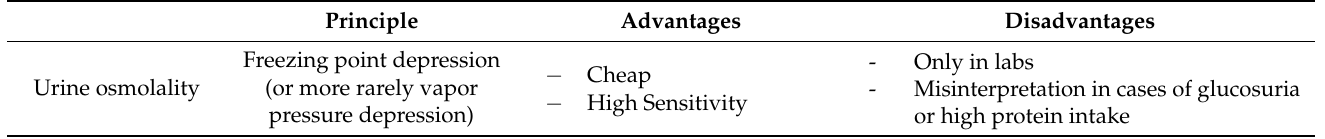
Table 1. Summary of principles, advantages and disadvantages of monitoring